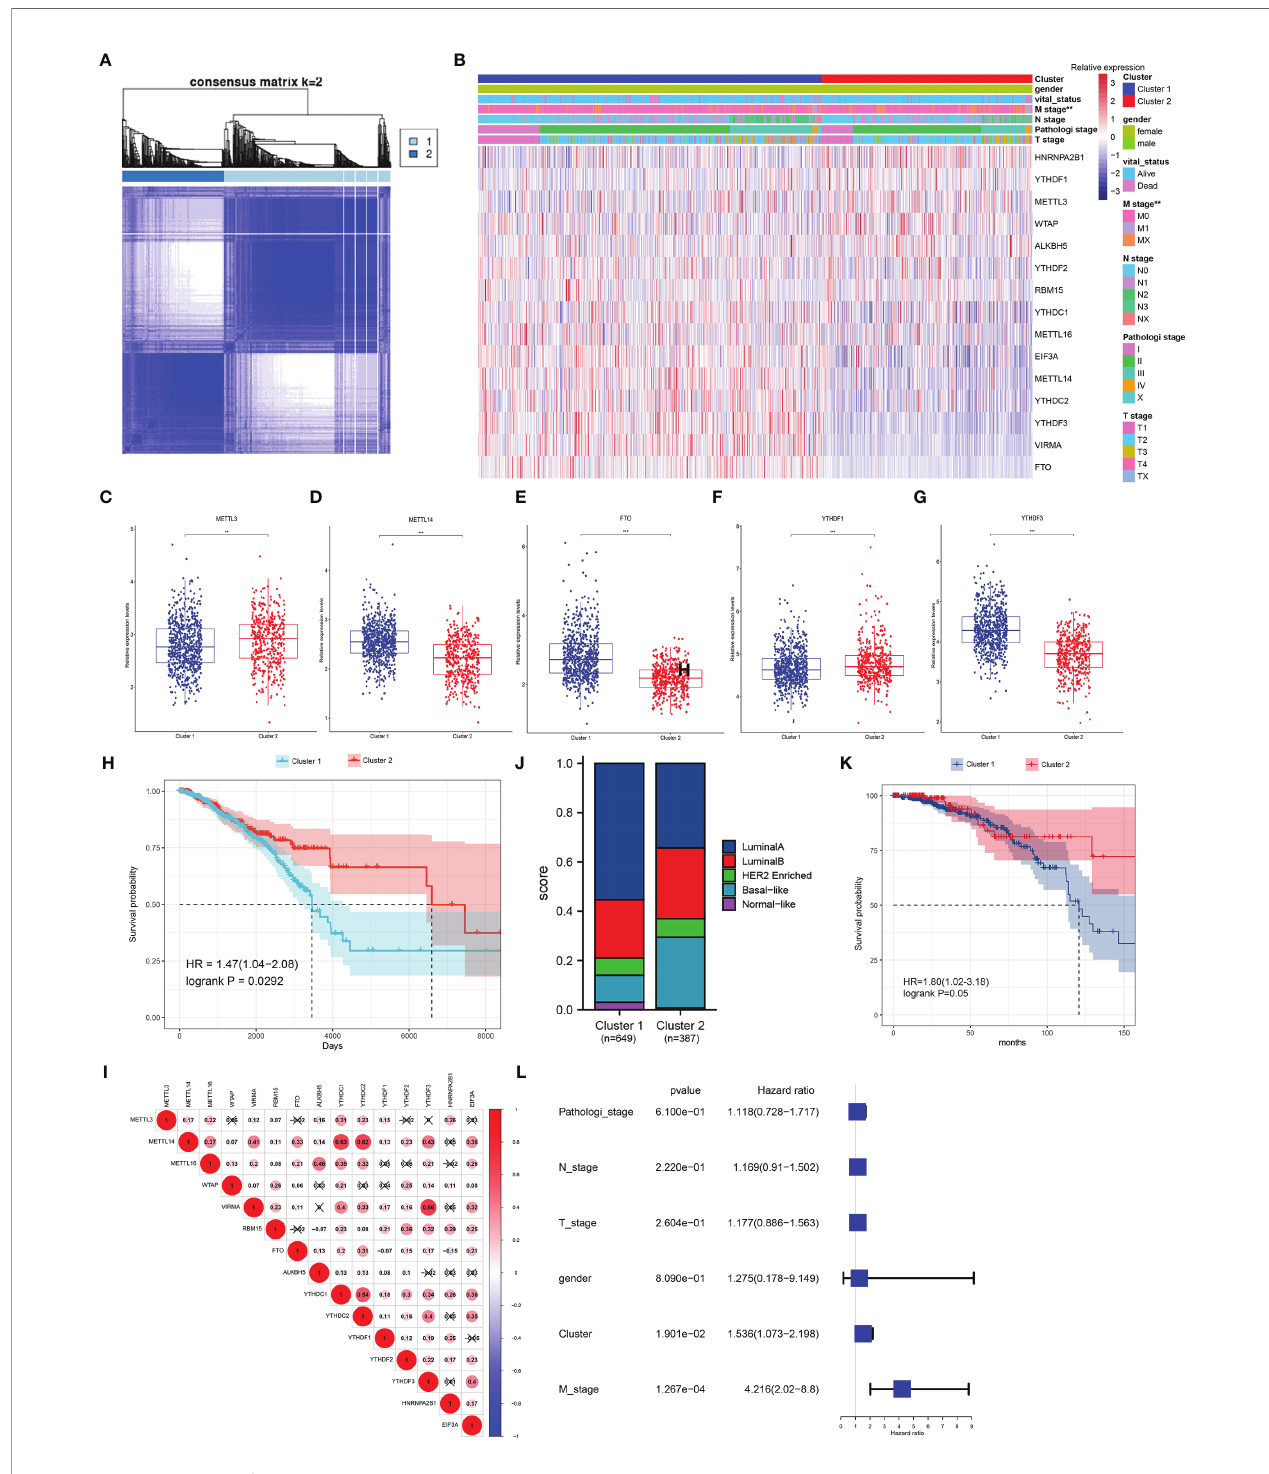
FIGURE 4 | Patterns of 15 m 6 A regulators and clinicopathological features in TCGA cohort. (A) Consensus clustering matrix for k = 2. (B) Unsupervised clustering of 15 m 6 A regulators and clinicopathological features of 1,079 breast cancer patients from TCGA data. The gender, survival status, TNM stage and pathological stage were used as patient annotations. (C – G) The relative expression levels of METTL3 (C) , METTL14 (D) , FTO (E) , YTHDF1 (F) and YTHDF3 (G) between cluster 1 and cluster 2, other regulators were represented in Supplementary Figure S4 . *p < 0.05, **p < 0.01, ***p < 0.001. (H) Kaplan-Meier curves of overall survival for patients with breast cancer in two clusters. (I) Spearman correlation analysis of the 15 m 6 A methylation regulators, positive correlation was marked with red. (J) The clinical subtypes of breast cancer patients in cluster 1 and cluster 2 based on the PAM50. (K) Kaplan-Meier curves of overall survival for patients with luminal A subtype in two clusters. (L) The multivariate Cox regression model analysis of different clinical